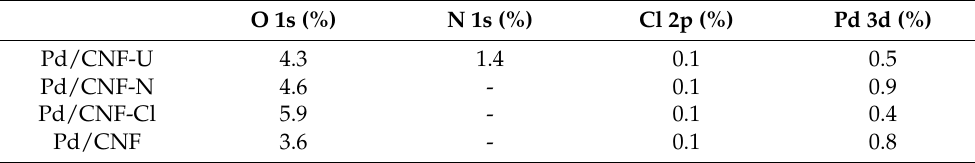
Figure 4. XPS profiles of N 1s in Pd/CNF-U. Table 2. XPS elemental atomic composition of supports and catalysts.